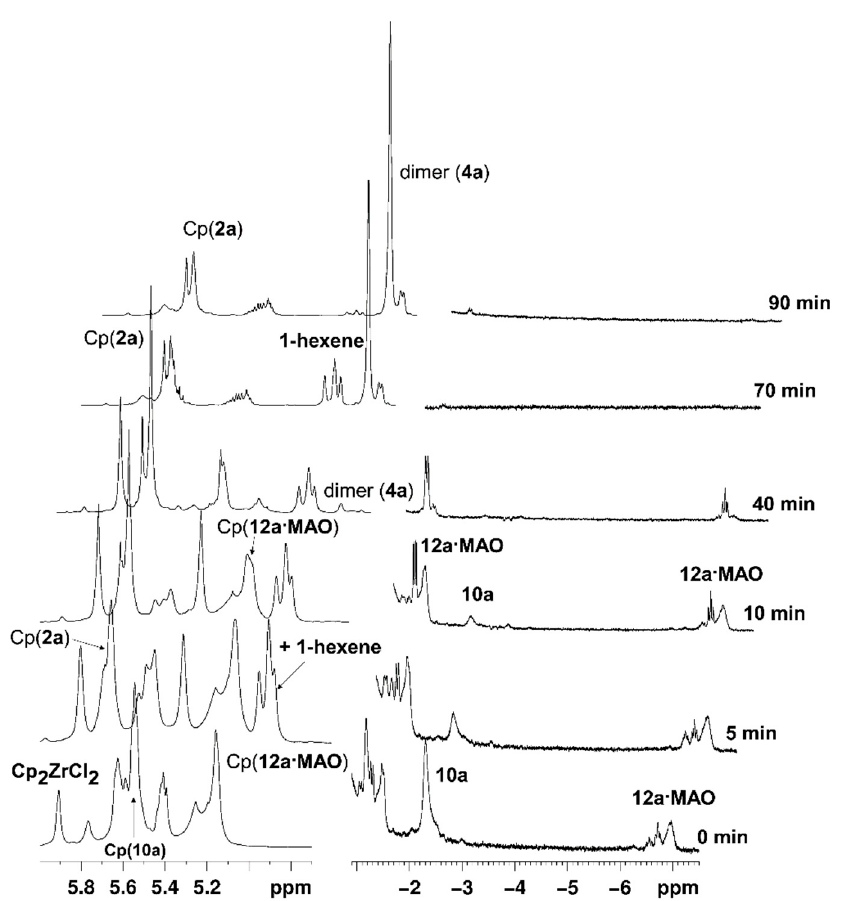
Figure 5. 1 H NMR monitoring of 1-hexene transformation in the system [Cp 2 ZrH 2 ] 2 -ClAlMe 2 -MMAO-12 in С 7 D 8 (T = 26 °C, intensity of upfield signals is increased).